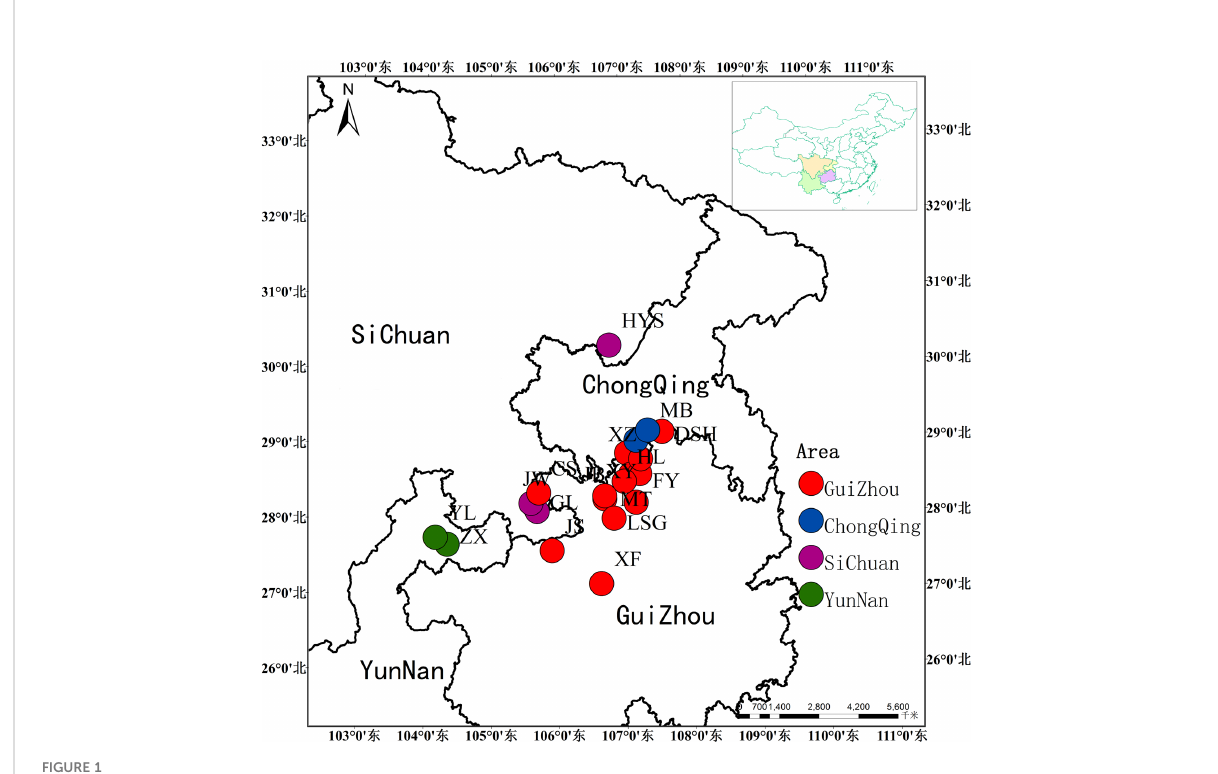
FIGURE 1 Sampling distribution of Ch. utilis in southwest China.